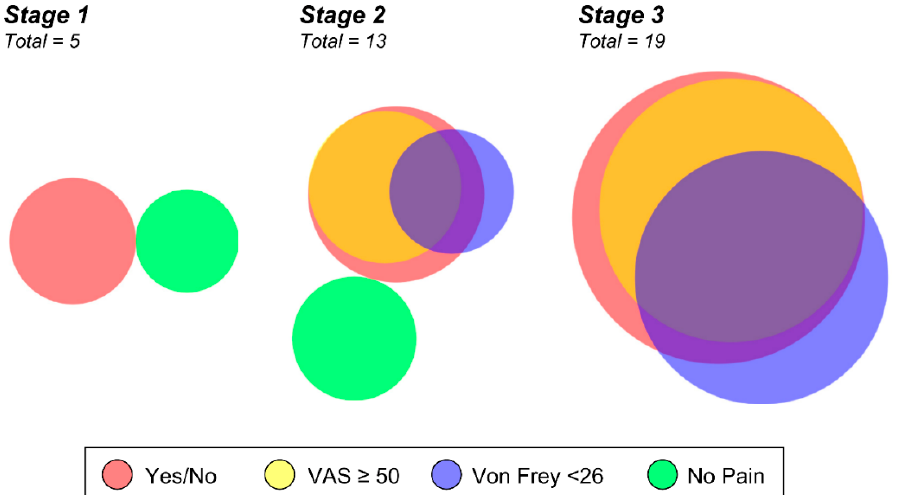
Figure 3. Venn diagram of summarized pain assessments. Proportional Venn Diagram of survey data illustrating lipedema subjects with a positive pain response to a simple yes or no survey (red), a VAS score greater than 50 (yellow, overlays as orange), a Von Frey threshold less than 26 (blue), and those without pain by the measures used (green). All controls reported no pain in their legs on yes/no questionnaire. Clusters are shown for participants with stage 1, 2, or 3 lipedema. Note that all patients with stage 3 lipedema reported pain in their legs (no green). Patients with stage 2 or 3 lipedema with pain in their legs rated the severity VAS > 50 (overlap between red and yellow), which is a clinically significant level. Some patients reported sensitivity to a filament-induced pain response who did not report pain in their legs or VAS > 50 (unique blue portion). Proportionality generated using DeepVenn (https://www.deepvenn.com, accessed on 22 February 2022 ).